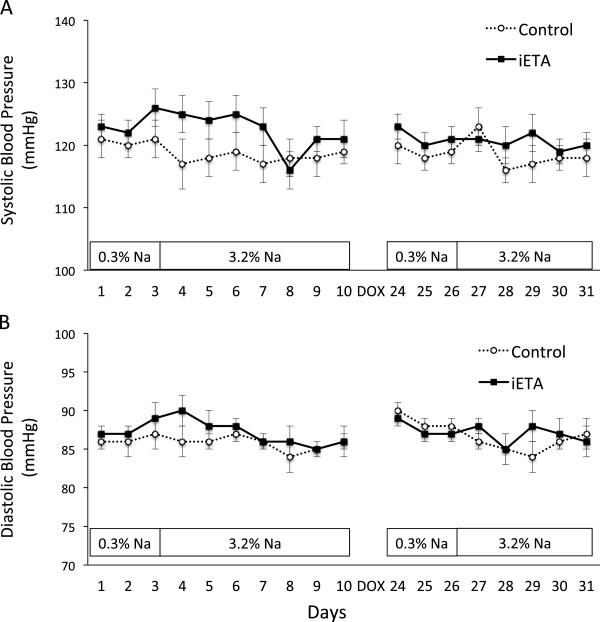
Systolic (Panel A) and diastolic (Panel B) BP in control and Pax8-rtTA/LC1/floxed ETA (iETA) mice before and after doxycycline (DOX) treatment. Animals were fed a normal (0.3%) Na diet for 3 days followed by a high (3.2%) Na diet for 5–7 days. DOX was given for 11 days, then BP recordings continued 5 days after discontinuation of DOX. BP was obtained by continuous radiotelemetry. Daily BP values are shown as the average of the every 10-minute recordings throughout that 24 hr period. N = 12 each data point.